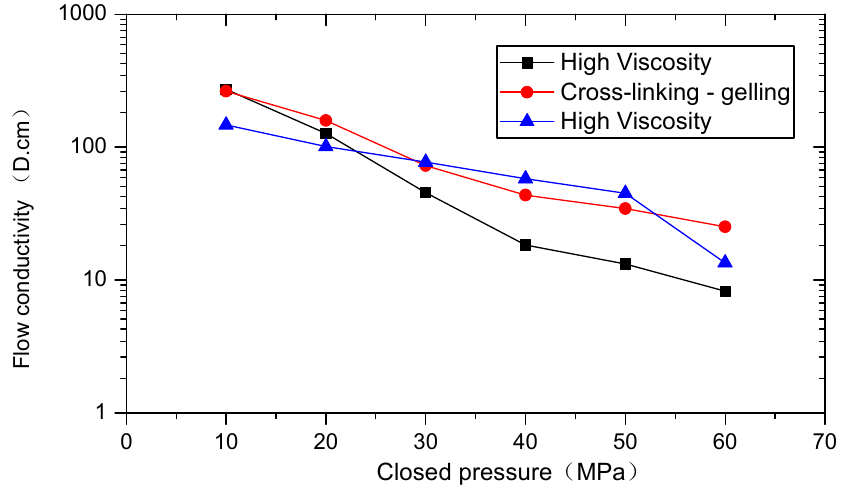
Figure 12. Conductivity of fracture-dissolved pore reservoirs under different closing pressures.